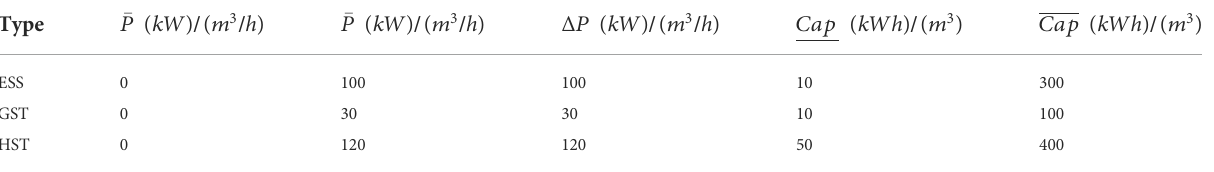
TABLE 2 Main parameters of energy storage units in